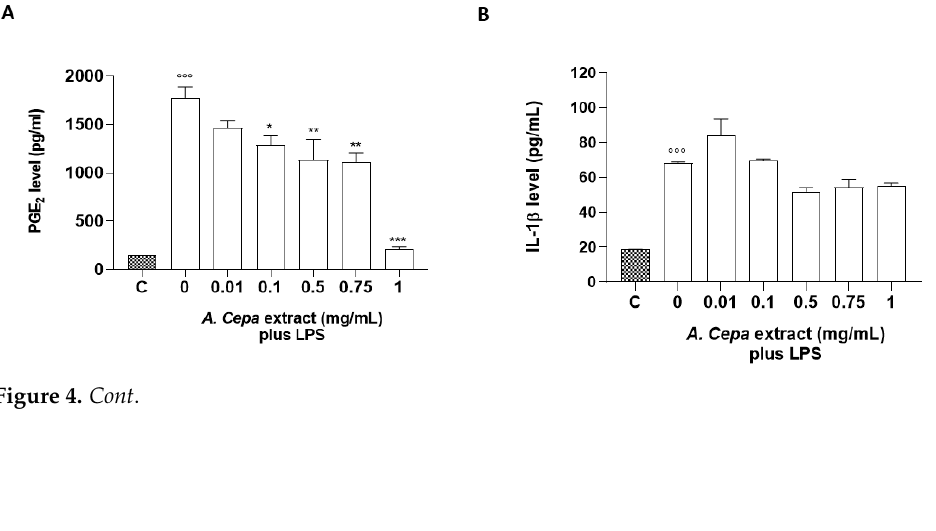
Figure 4. Effect of the A. cepa extract on LPS-induced PGE 2 , IL- 1β, nitrite , and TNF- α production. J774 cells were pre-treated for 2 h with increasing concentrations of the extract (0.01, 0.05, 0.1, 0.5, 0.75, and 1.0 mg/mL) prior to LPS stimulation (10 µg/mL) for 24 h. Unstimulated J774 cells acted as a negative control. Nitrites ( C ), stable end-products of NO, were measured in the supernatants by the Griess reaction, whereas PGE 2 ( A ), IL- 1β ( B ), and TNF- α ( D ) were measured by ELISA. °°° p < 0.001 vs. unstimulated cells C, *** p < 0.001, ** p < 0.01, and * p < 0.05 vs. LPS alone. 3. Discussion In this work, a chemically characterized A. cepa extract rich in quercetin and its derivatives was obtained from an onion tunic with a conventional extraction method optimized by DoE. Then, in view of possible applications as a food supplement ingredient, the extract was subjected to preliminary in vitro studies, such as the determi- nation of its bioaccessibility and anti-inflammatory activity. First, four extracts obtained from different A. cepa varieties were tested to evaluate the TPC and select the variety that provided the extract with the highest content of polyphenols. Then, five different querce- tin derivatives (quercetin 3,4 ’ -diglucoside, quercetin 3-monoglucoside, quercetin 4′ - monoglucoside, quercetin 4′ -methyl- 3′ - glucoside, and quercetin aglycone) were identi- fied and quantified in extracts obtained from the tunicate bulb, tunic, and bulb, to select the onion part containing the highest concentrations of quercetin and its derivatives, with tunic providing the richest part compared to tunicate bulb and bulb. Then, profiling of the flavonoids present in the tunic A. cepa Golden variety extract was performed. Fourteen compounds were identified. Furthermore, the increases in some quercetin derivatives fol- lowing the gastro-duodenal digestion process support the bioaccessibility of these bioac- tive compounds. In particular, the chromatographic peak areas of quercetin and its monoglucoside derivatives were found to increase after the in vitro simulated gastro-du- odenal digestion process, while those corresponding to dihexoside derivatives were not recorded in the chromatogram of the digested extract. These results can be explained by both the degradation of dihexoside derivatives to quercetin and its monoglucoside deriv- atives and the possible release of quercetin derivatives from the onion matrix. These re- sults are unsurprising, as it is known that onion tunics contain plant cell wall (PCW) com-